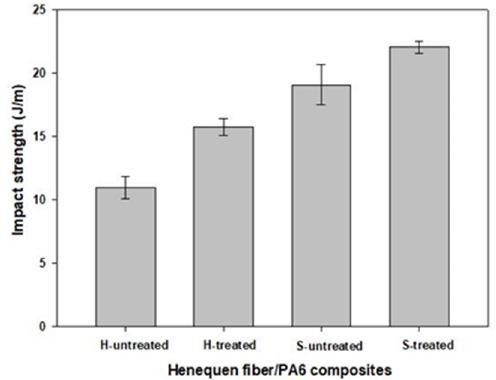
Figure 11. Izod impact strengths for untreated or alkali-treated henequen fiber/PA6 composites produced via different fiber feeding routes.